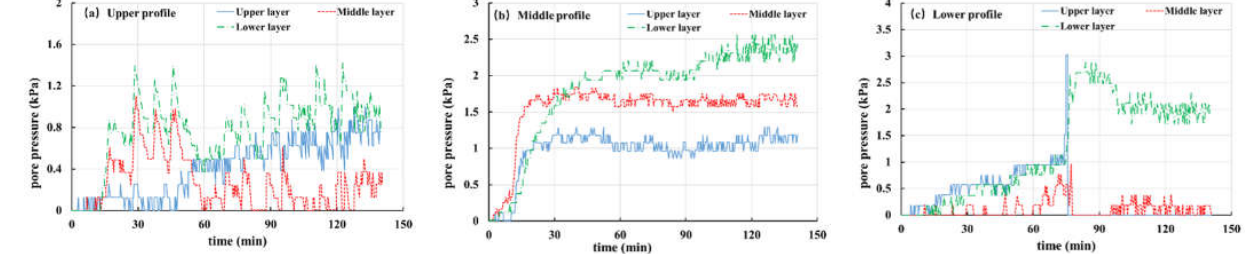
Figure 12. Curves of pore pressure in Test 2 (20 mm, 60 mm/h): ( a ) Upper profile; ( b ) Middle profile; ( c ) Lower profile.